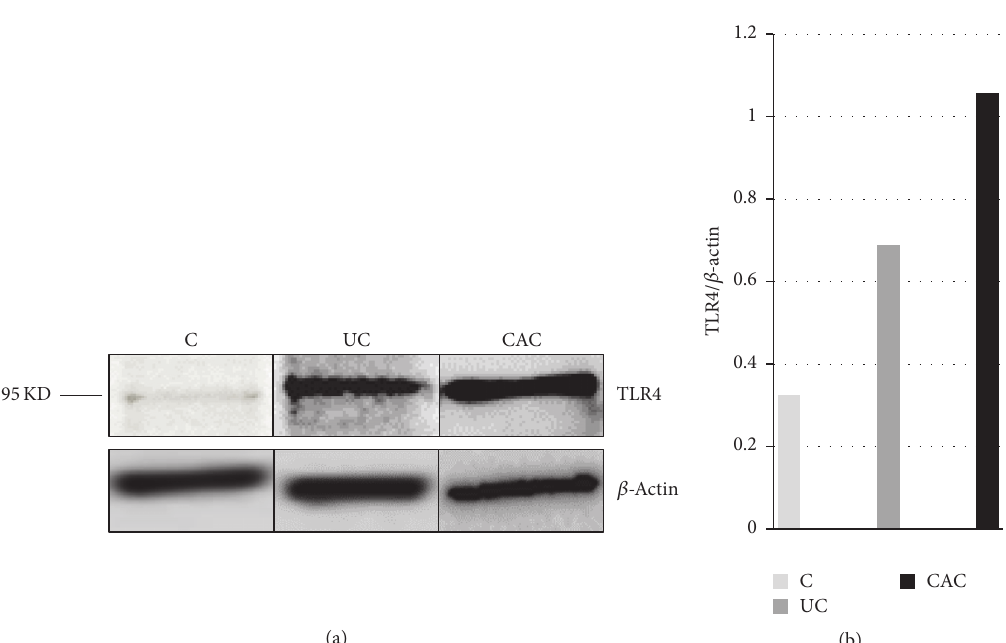
Figure 7: The expressions of TLR4 in colonic mucosa of UC and CAC patients detected by Western blot. (a) Representative Western blot analysis of total biopsies homogenate from colonic mucosa of active UC and CAC patients. A TLR4 specific polyclonal antibody recognized a protein whose molecular weight was approximately 95 kDa. (b) The relative intensity of TLR4 (C: control, colonic mucosa, 𝑛 = 3 ; UC: ulcerative colitis, 𝑛 = 5 ; CAC: colitis associated cancer, 𝑛 = 3 ).